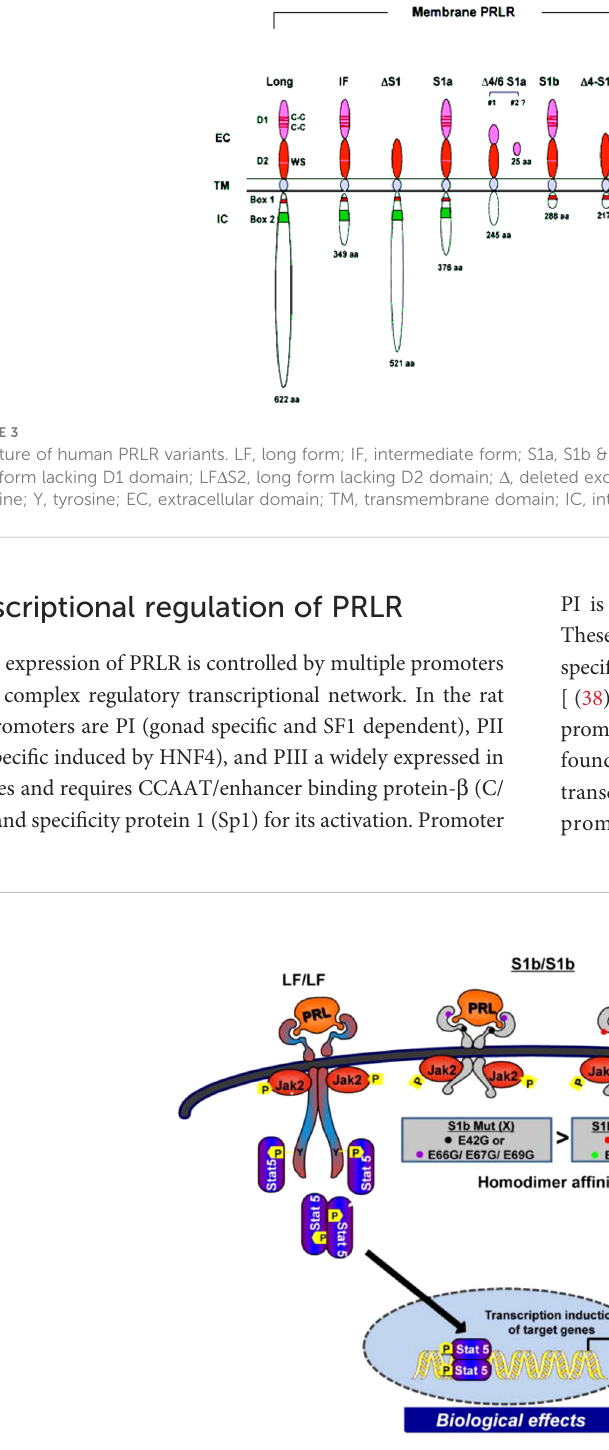
FIGURE 4 Mechanism of inhibitory action of short form S1b PRLR on PRL-induced long-from (LF) receptor signaling (reproduced from reference 12). Homodimer of the hPRLR long form (LF) mediates PRL stimulated JAK2/Stat5 signaling required for transcription/expression PRL/PRLR target genes which are essential for the various biological effects of the hormone. The inhibitory action of short form S1b on LF ’ s function induced by PRL results from LF/SF heterodimer formation and marked reduction of LF/LF homodimers which are required by Stat5